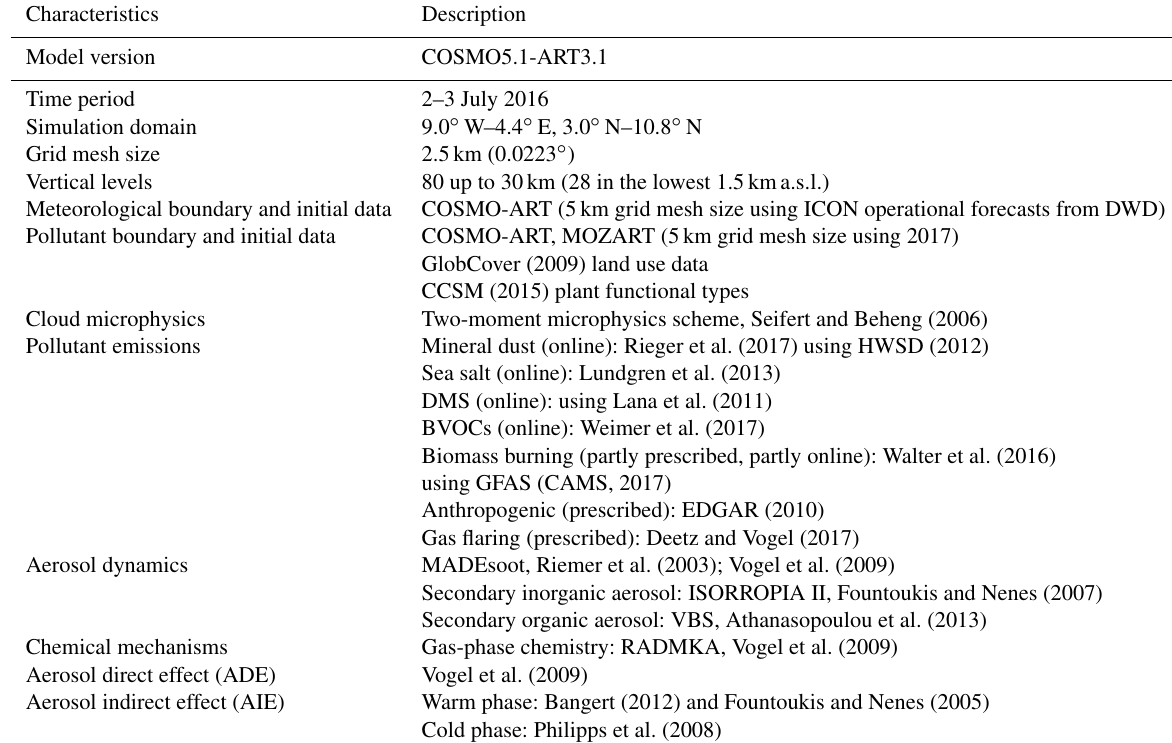
Table A1. COSMO-ART model configuration used for this